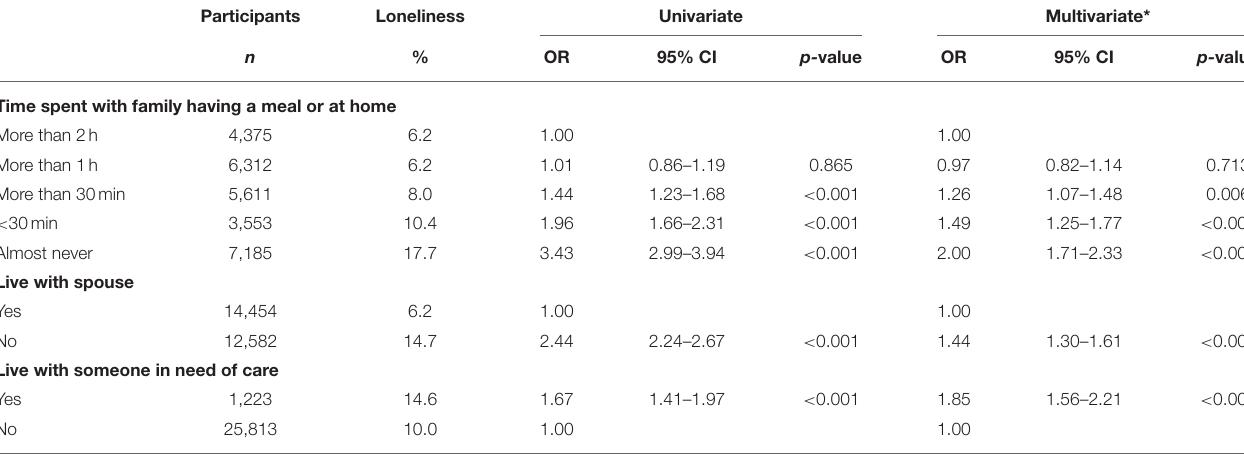
TABLE 2 | Association between time spent with family having a meal or at home, and loneliness. Participants Loneliness Univariate Multivariate* n % OR 95% CI p- value OR 95% CI p-